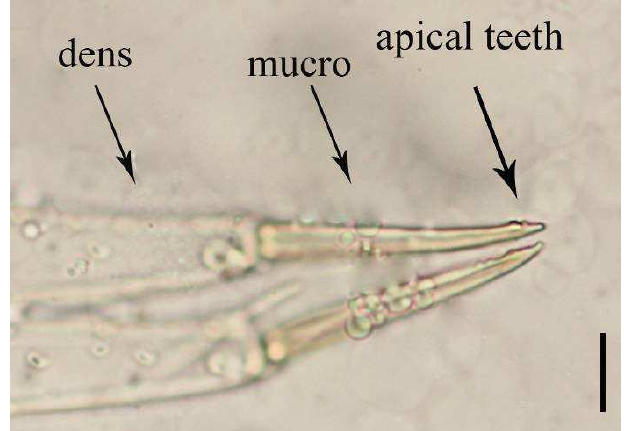
F IGURE 14. Mucro with two apical teeth in C. albinus (scale: 100 µm) .